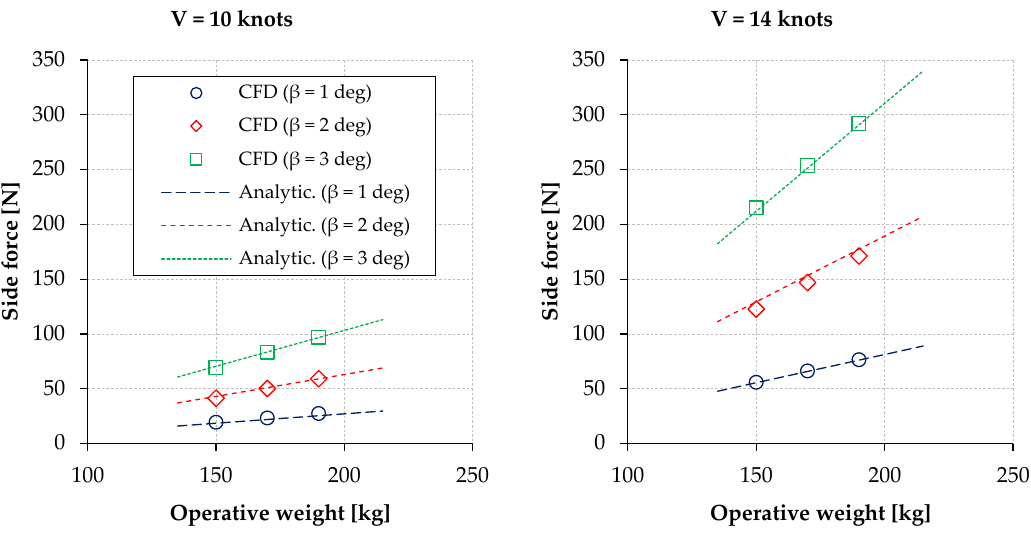
Figure 3. CFD and analytical solutions of demihull side force for the reference hull.